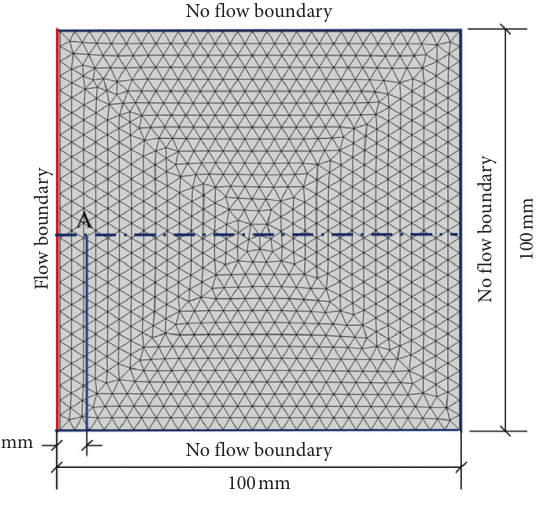
Figure 6: Numerical calculation